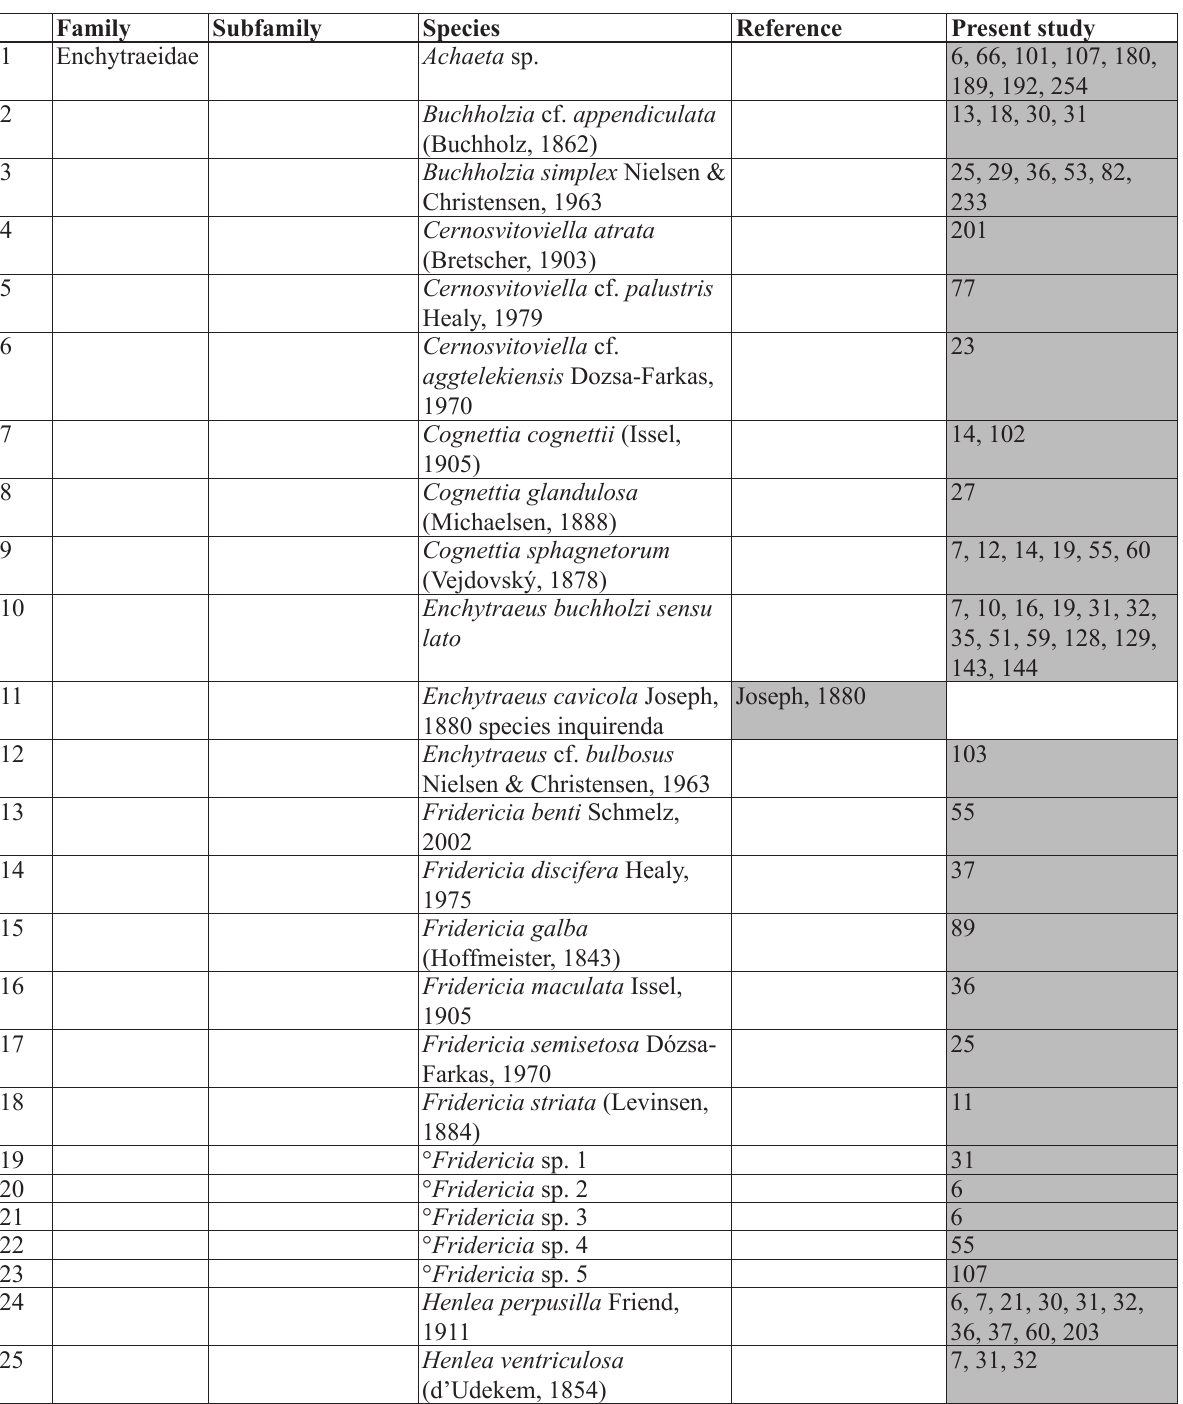
Table 1 - List of oligochaetes (Annelida, Clitellata) reported from ground waters in Slovenia. Original data are integrated with lit- erature in an updated checklist of Slovenian groundwater oligochaetes. The new findings reported here are referred by the number of the locality adopted in Appendix 1. Species we consider to be stygobiotic are marked with an asterisk; the symbol ° indicates that the species is new to